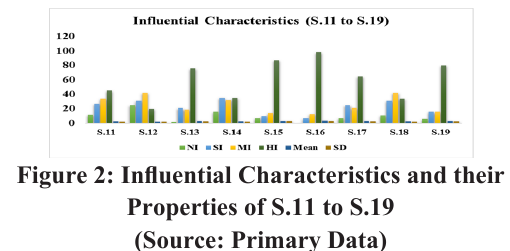
Figure 2: Influential Characteristics and their Properties of S.11 to S.19